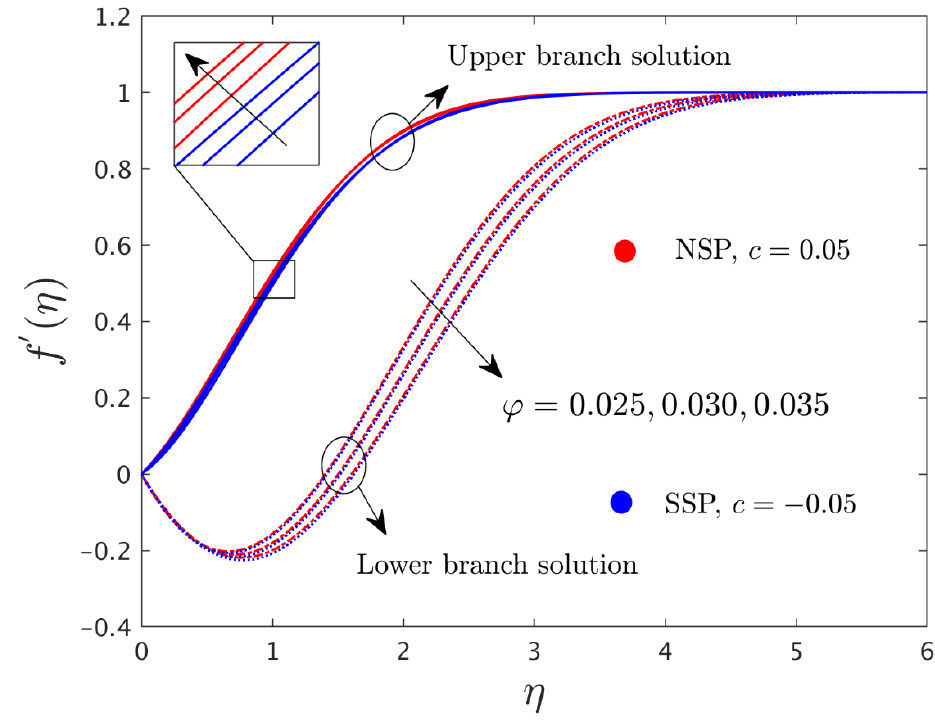
Figure 2. The f (cid:48) ( η ) in the direction of the x -axis for varying ϕ Figure 2. The () '  f in the direction of the x-axis for varying  .